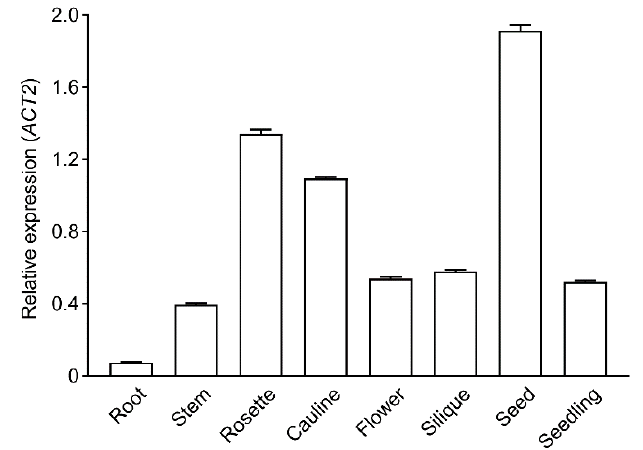
Figure 1. Expression pattern of EDA3 in different tissues. Transcript abundances of EDA3 in different tissues of Arabidopsis thaliana wild-type plants, together with the whole seedlings, were determined by qRT-PCR and normalized against the levels of ACTIN2 ( ACT2 ) (as a reference). Data represent means ± SEM ( n = 3).